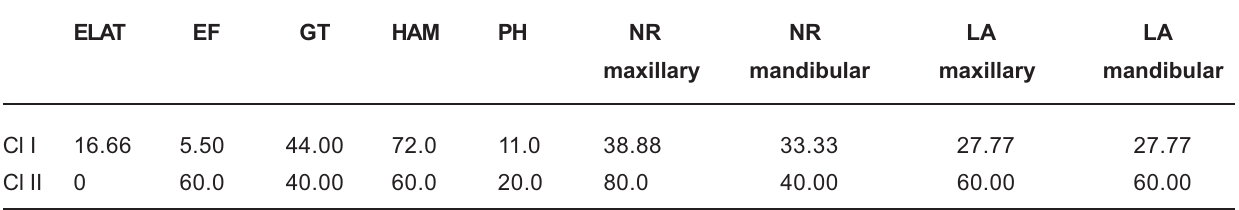
RPD: removable partial denture; ELAT: extrusion of the lower anterior teeth; EF: epulis fissuratum; GT: growth of the tuberosities; HAM: hypermobility of anterior part of the maxillae; PH: papillary hyperplasia; NR: necessity for replacements; LA: lack of adaptation.